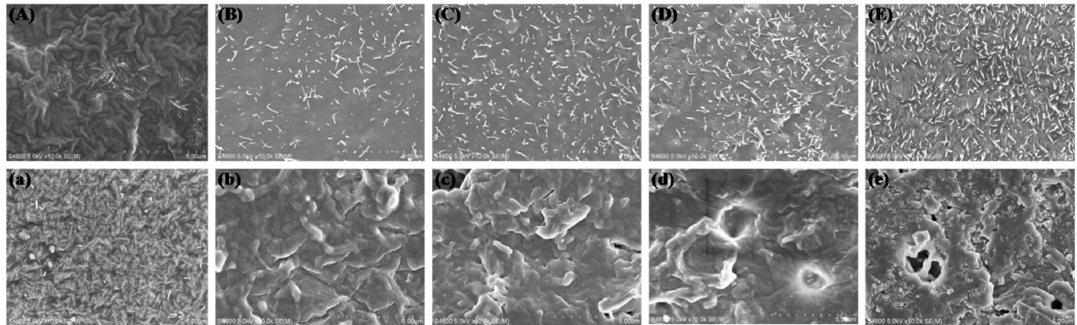
Figure 9. The SEM images of all LPH films’ surface in PBS solution(pH=7.4)in vitro before and after degradation ( A – E is from LPH ‐ 0 to LPH ‐ 8 before degradation; a – e is from LPH ‐ 0 to LPH ‐ 8 after 49 days degradation; all images magnified 10.0k).